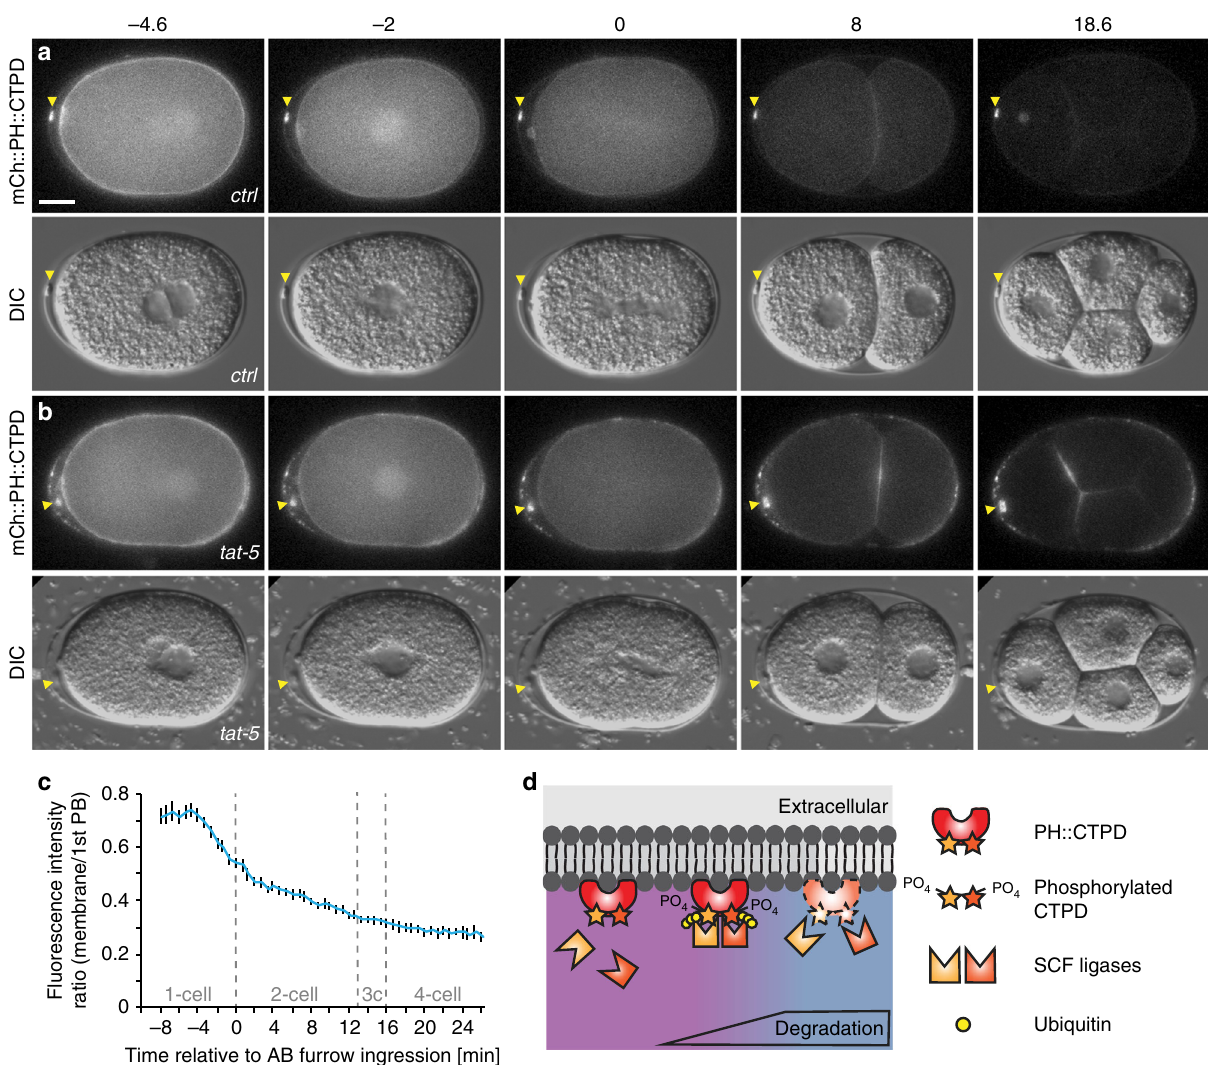
Fig. 3 The CTPD domain leads to transient degradation and labelling of extracellular vesicles. a An mCherry and CTPD-tagged PH reporter localizes to the plasma membrane in one-cell embryos, but begins to be degraded during mitosis. Weaker fl uorescence persists in embryonic cells from the two-cell stage on, but polar bodies remain brightly labelled (arrowhead, n = 42). Scale bar: 10 µ m. b After tat-5 knockdown, the mCh::PH::CTPD reporter still degrades, but bright patches of extracellular vesicles are visible in the eggshell, fl oating around the embryo, and on the embryo surface, in addition to the brightly labelled polar bodies (arrowhead, n = 43). See also Supplementary Movie 2. c Loss of mCh::PH::CTPD fl uorescence from the cell surface begins ~3 min before cytokinetic furrow ingression, but degradation tapers off leaving residual mCh::PH::CTPD fl uorescence after the two-cell stage. Fluorescence intensity was normalized to the fi rst polar body to correct for photobleaching. Bars represent mean ± s.e.m. ( n = 5 – 12). Source data are provided as a Source Data fi le. d Phosphorylation of the CTPD degrons leads to recognition of the CTPD by multiple SCF ubiquitin ligases, ubiquitination, and